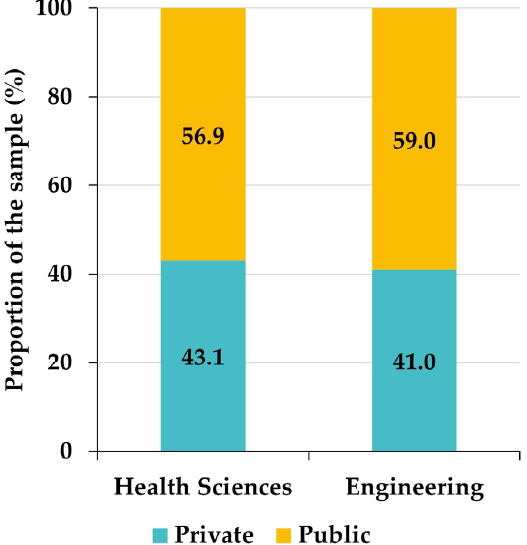
Figure 4. Distribution of participants by area of knowledge and university tenure.